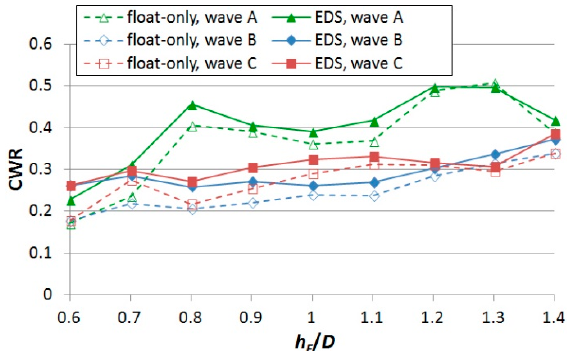
Figure 14. Comparison between CWR of EDS and float -only system at best configuration.